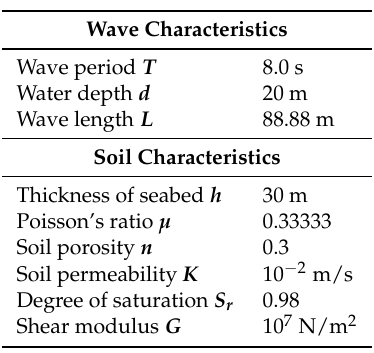
Table 1. Input data for numerical examples demonstrating effects of lateral boundary conditions.